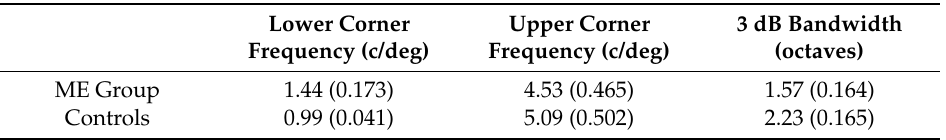
Table 1. Mean lower and upper corner frequencies, and bandwidths (±1 SE) of the contrast sensitivity functions for the ME group and controls.